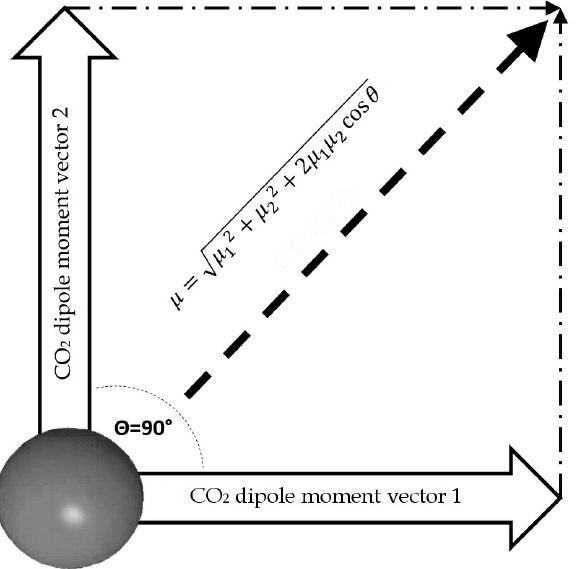
Figure 7. Outline of total dipole moment of dimer configuration, assuming that vectors of each CO 2 molecule are coplanar. The results are plotted in Figure 8. According to the data reported in Tab. 1, the bond angles used for calculations range from 180° to 160°. The data are based on the partial charge calculations from § 3.1, and as comparison, based on partial charge value according to [3]. They calculate a charge separation with a negative partial charge of − 0.36 e on the Oxygen atoms, a positive partial charge of +0.72 e on the Carbon atom (Figure 2) and a C=O partial charge separation of 0.36 e. These results are based on the CHELPG scheme (CHarges from ELectrostatic Potentials using a Grid based method, described in [39]); the atomic charges are fitted to reproduce the molecular electrostatic potential (MEP) at a number of points around the molecule.